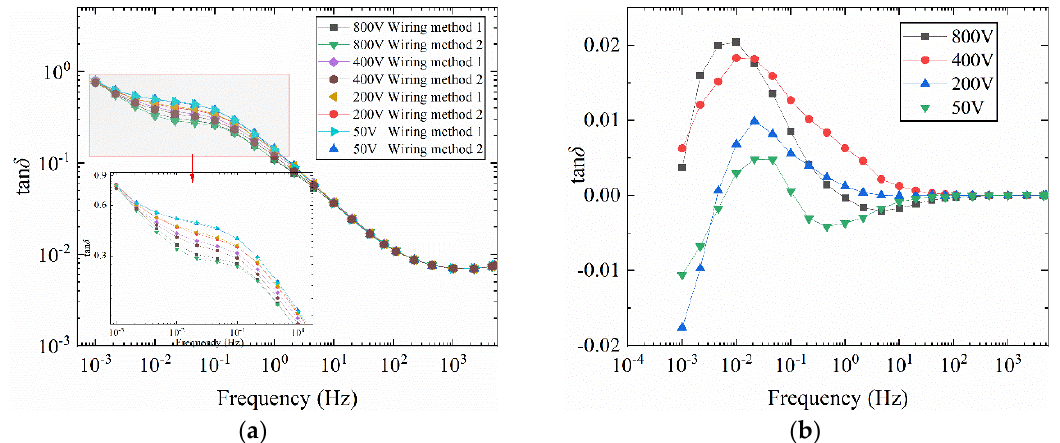
Figure 12. Influence of di ff erent wiring methods on tan δ - f curve of bushing model at di ff erent voltages (40 ◦ C). ( a ) tan δ - f , ( b ) di ff erence curves of tan δ - f